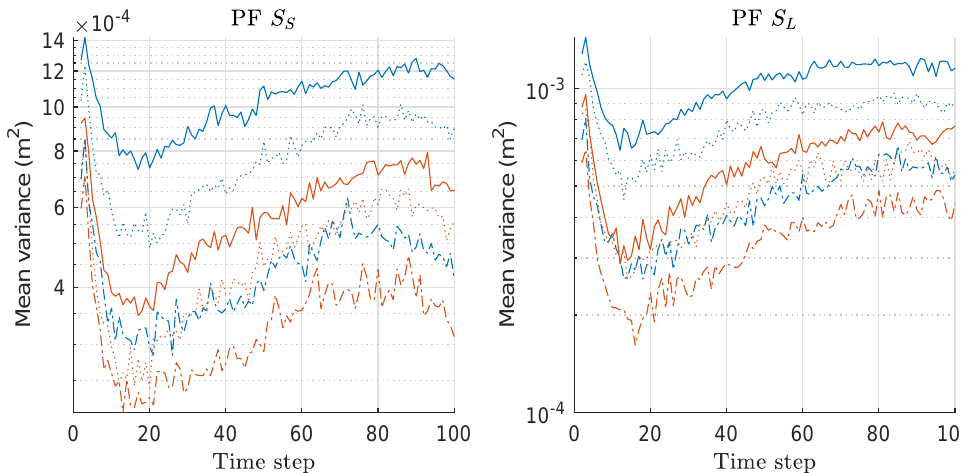
Figure 3. Mean-variance of the weights of particles over 300 runs with 1000 particles for PF and MPF. These results are associated with the results of MDE and mean-risk of Figures 1 and 2. Legend: line style (dash-dot: M = 2; dotted: M = 5; solid: M = 10); (line color: blue: PF; red: